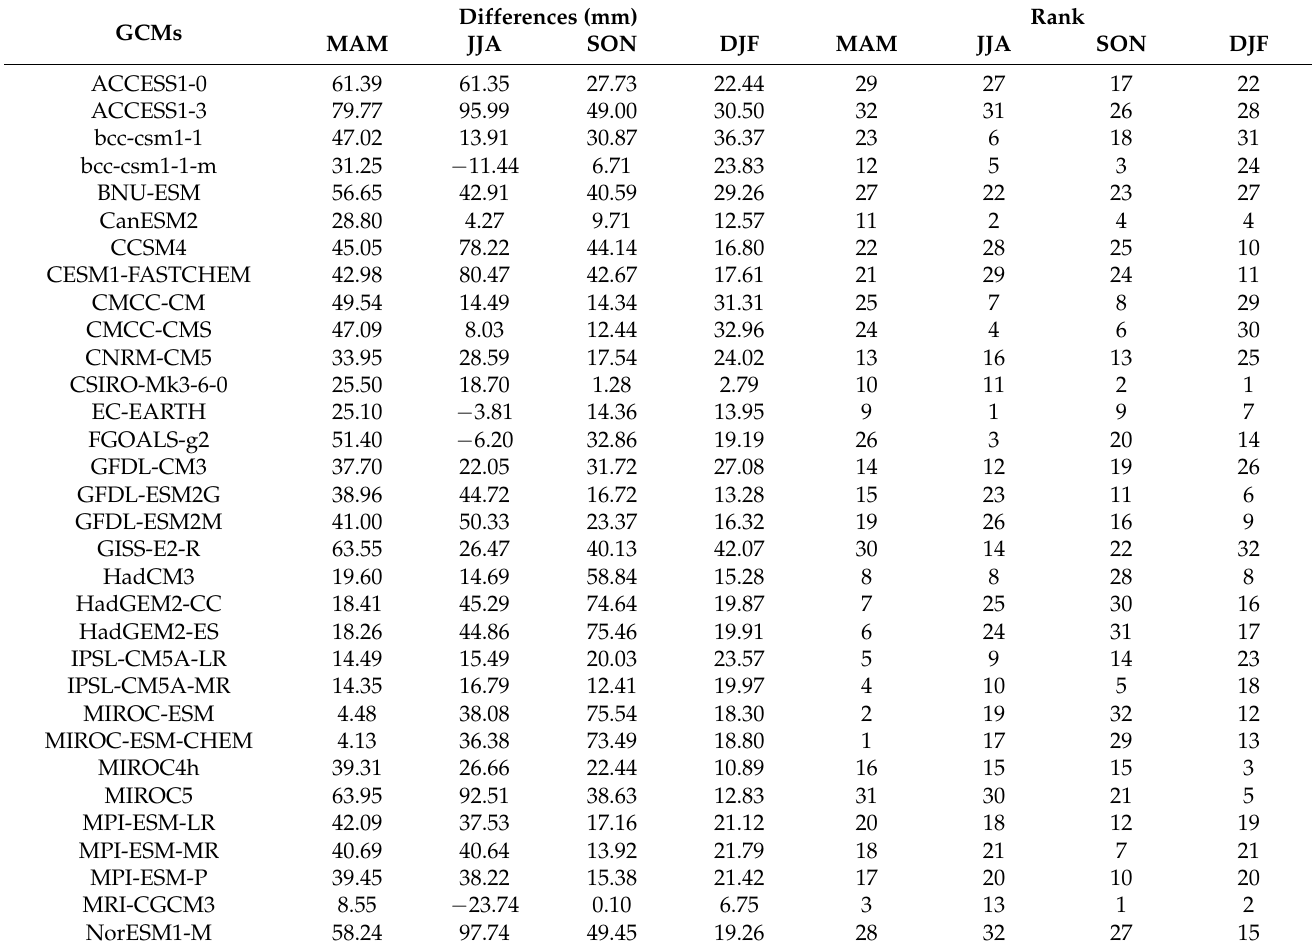
Table 3. Deviation of the simulation between nodes in the OBS and each